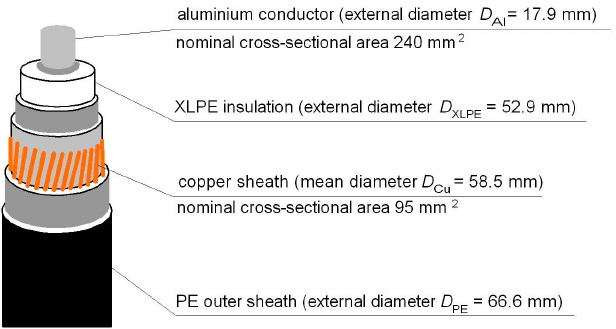
Figure 3. A simplified view of the power cable used in the analyzed case.